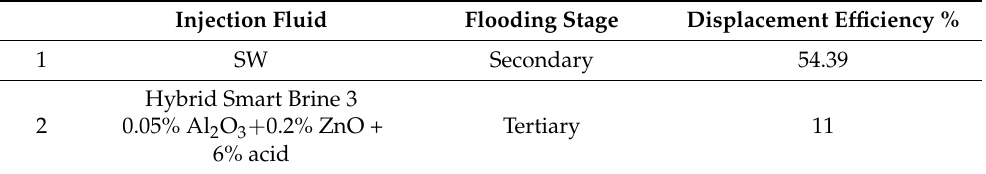
Table 18. Summary of CF11.